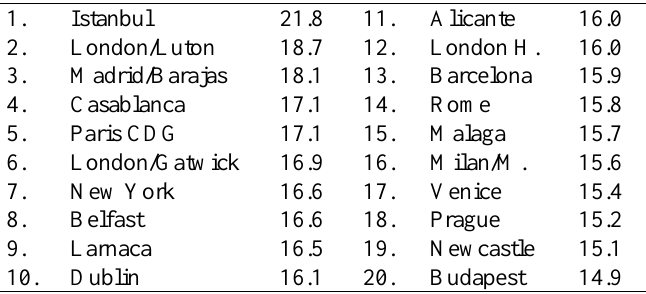
Table 1. Average delay in minutes per movement (July